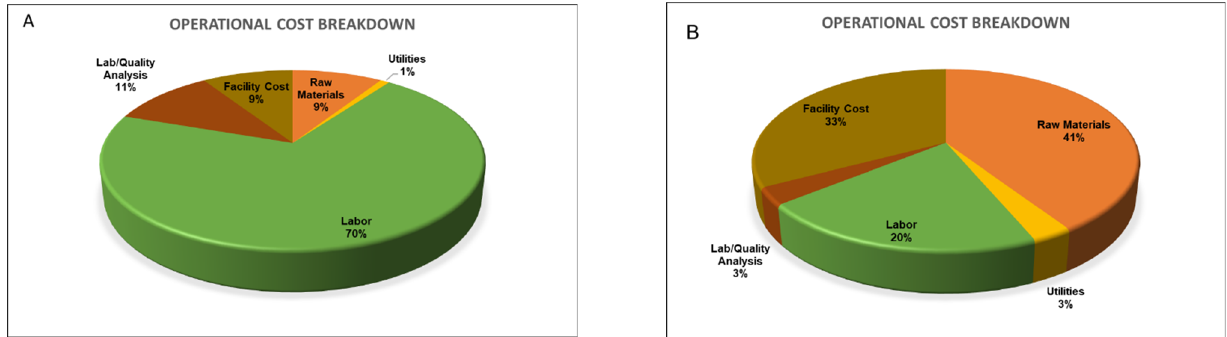
Figure 3. Operating cost breakdown for the carrot puree production plant: ( A ) base case and ( B ) case 2. Table 5. Annual labor demand and cost for the puree production plant (base case).